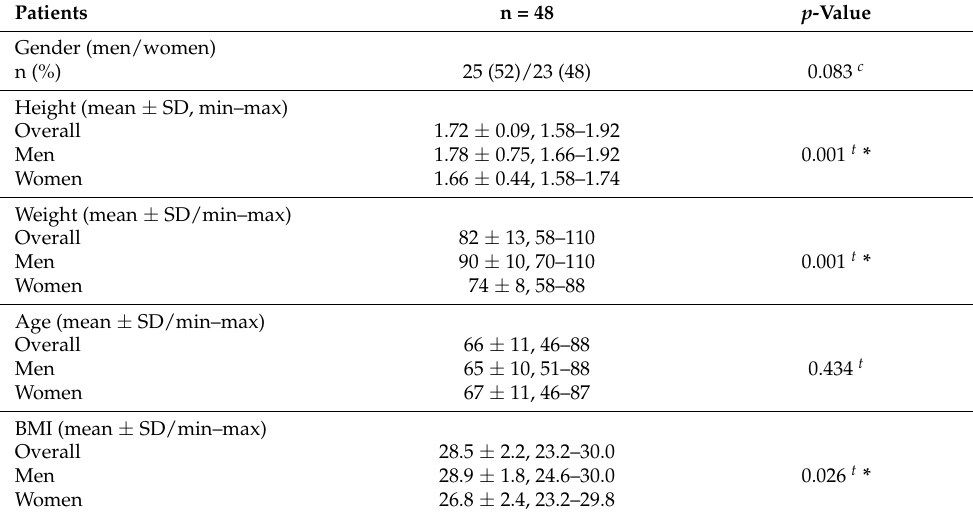
Table 1. Demographics, absolute and relative frequencies. arithmetic mean [mean ± standard deviation (SD),